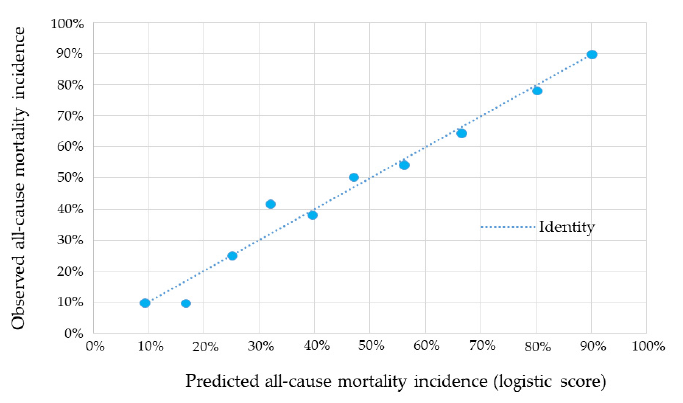
Figure 3. Concordance between the long-term mortality incidence predicted by the score and that observed in the entire population, stratified by deciles of risk.